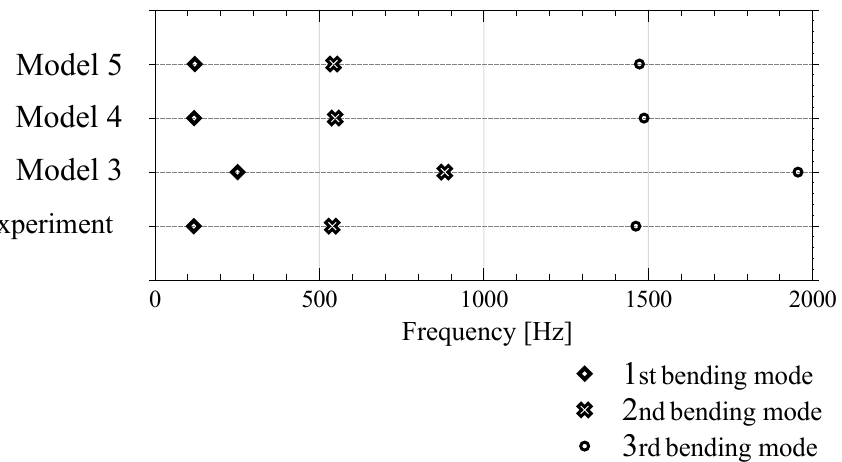
Figure 6. Experimental and further lumped-parameter finite element and analytic simulation results for the eigenfrequencies related to the first three bending modes of the first specimen. Experiment: contact-free measurement setup. Modelling approach 3 : tied coupling of a point mass. Modelling approach 4 : tied coupling of a point mass and a rotary inertia. Modelling approach 5 : Analytical description of a simplified model according to the Euler–Bernoulli